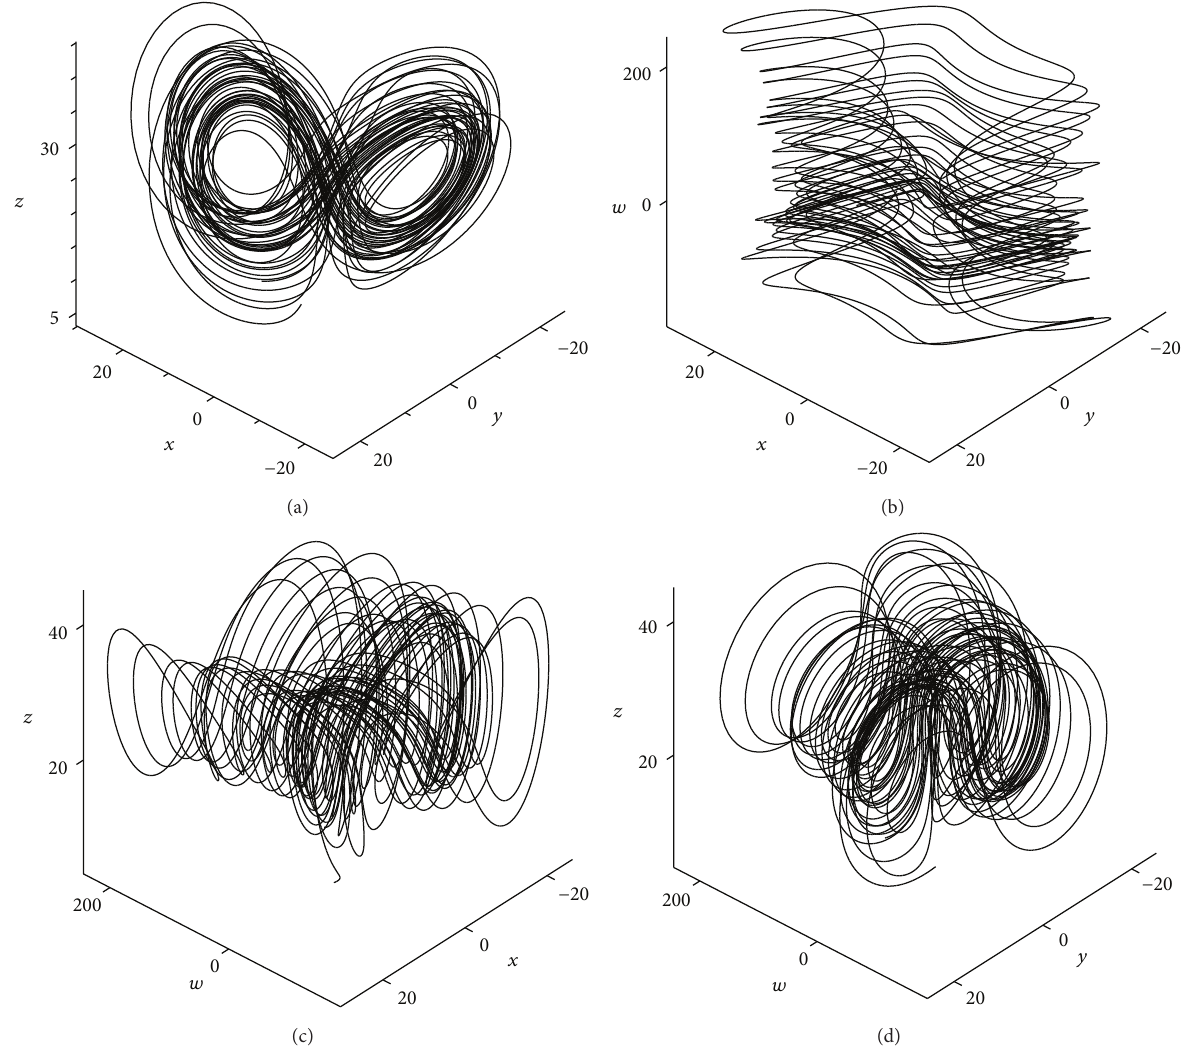
Figure 1: Typical dynamical behavior of hyperchaotic Lorenz system. (a) Projection in (𝑥,𝑦,𝑧) space; (b) projection in (𝑤, 𝑥,𝑦) space; (c) projection in (𝑥,𝑤, 𝑧) space; (d) projection in (𝑤,𝑦,𝑧)